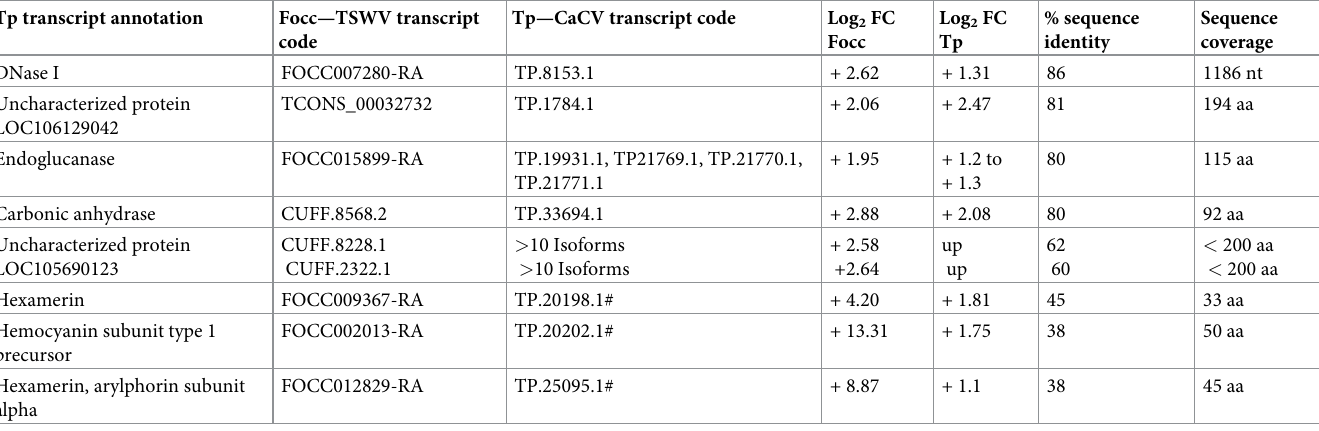
Table 4. List of conserved up-regulated transcript sequences in two adult-stage thrips—tospovirus